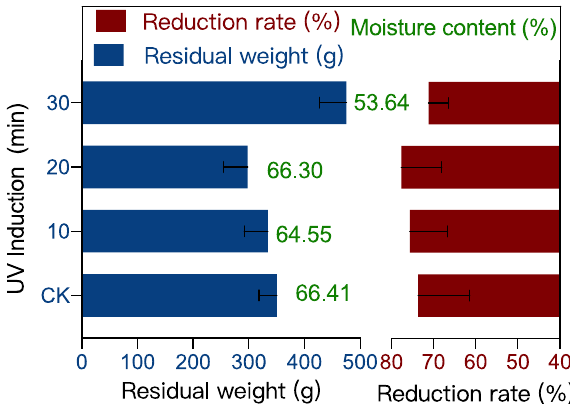
Figure 1. Amount of remaining food waste and the reduction of food and water reduction at UV- induced BSF versus the control (CK) after 5 days of feeding food waste ( p <